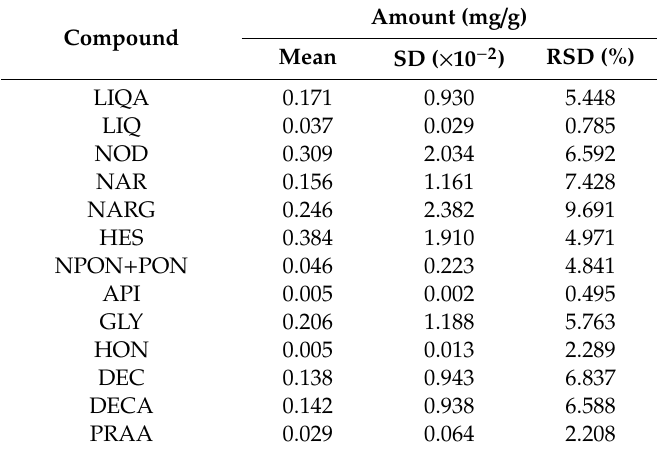
Table 5. Amount of the 14 marker components in SDGT based on LC–MS / MS analysis ( n =